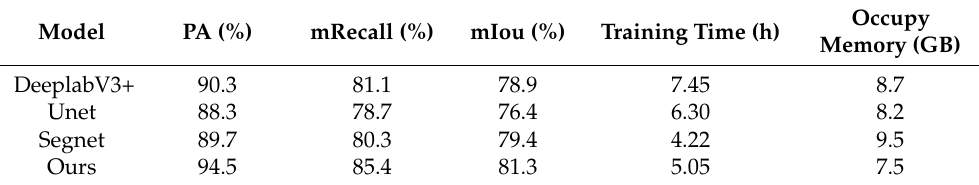
Table 6. Comparison of evaluation indexes of different segmentation